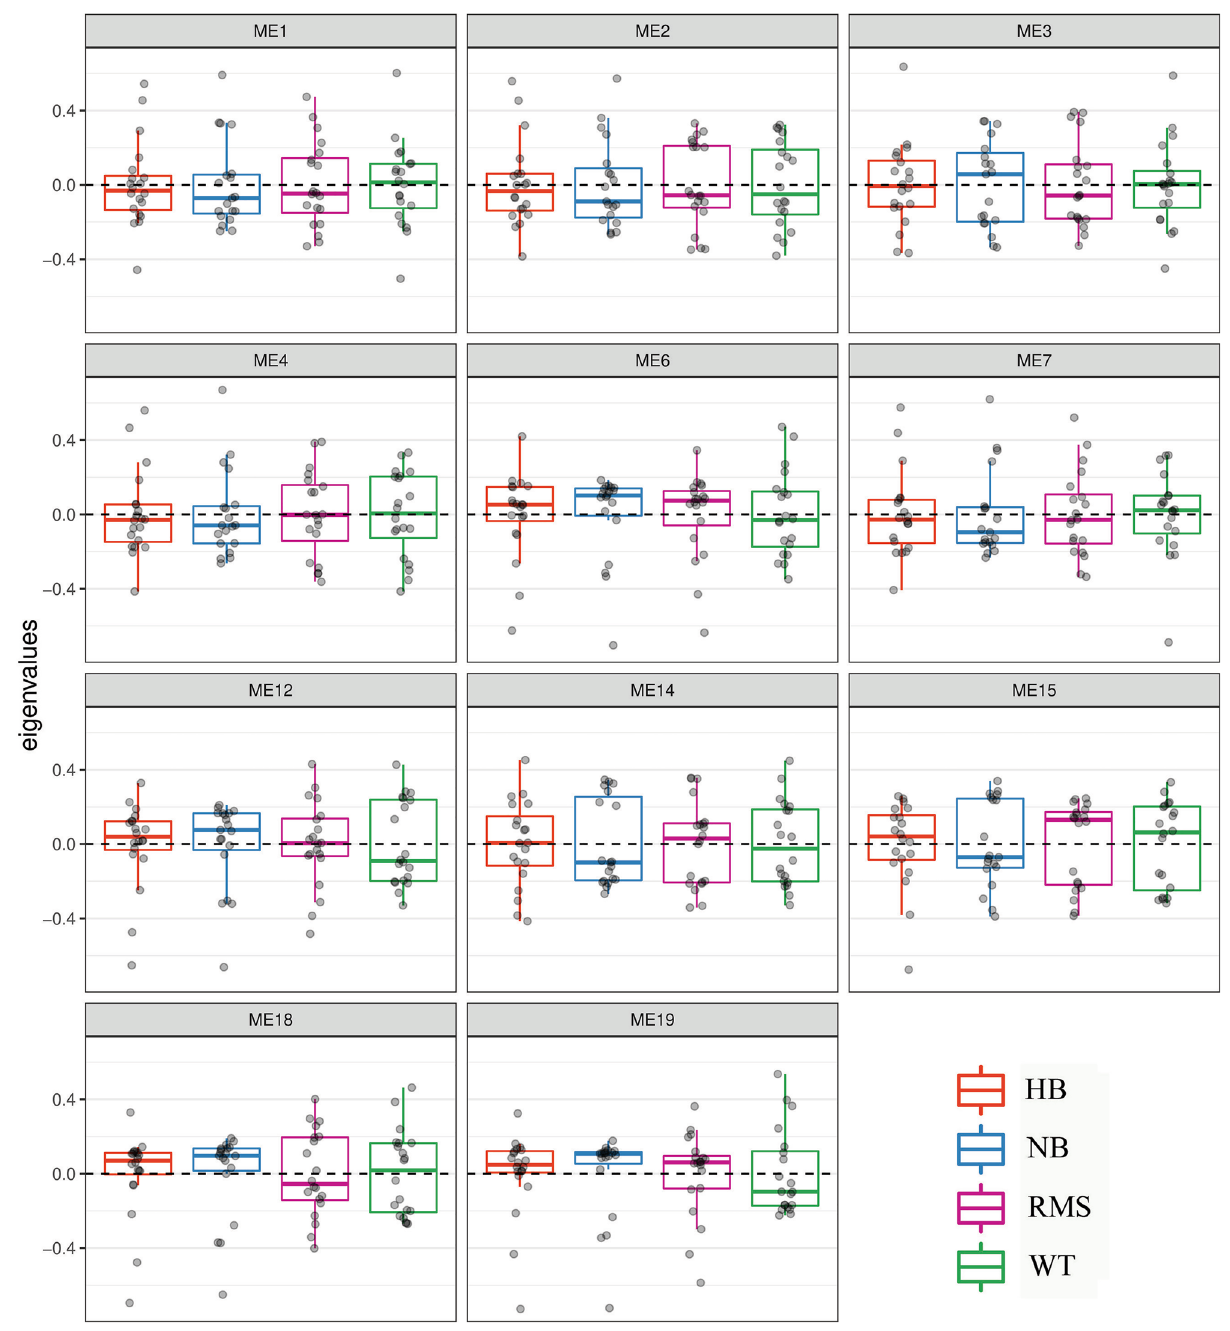
Figure 3. Weighted Gene Co-expression Network Analysis (WGCNA) Module Eigengenes (ME). The boxplots show ME scores (y-axis) across histotypes (x-axis) for modules obtained through a WGCNA. The genes included in all ME and the top functions are reported in Supplementary Table 6. HB: red; NB: blue; RMS: purple; WT: